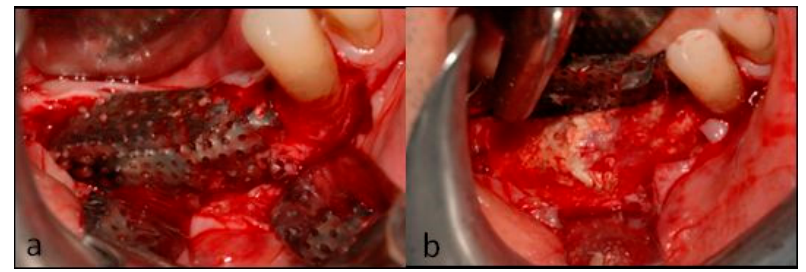
Figure 9. At the second surgery, ( a ) the flap was opened, and ( b ) the mesh was retrieved.